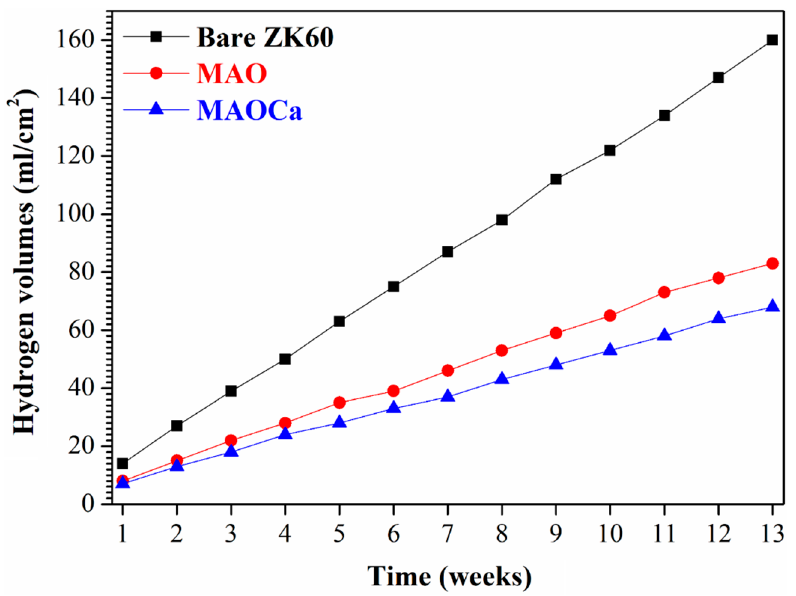
Figure 4. Hydrogen evolution in SBF solution for the bare ZK60 and samples coated in the MAO and MAOCa treatments.